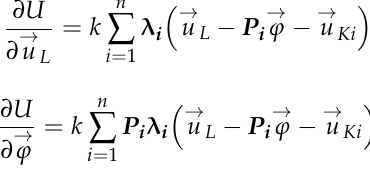
wherein 𝑺 𝑳 represents the antisymmetric tensor (5) related to the vector of the first mo- ment of inertia respecting the origin L of the local coordinate system and 𝑱 𝑳 is the tensor of inertia (6) respecting the origin L of the local coordinate system. The second term of Equation (2) for the generalised position → u L (7) and the vector of angular position vector of position